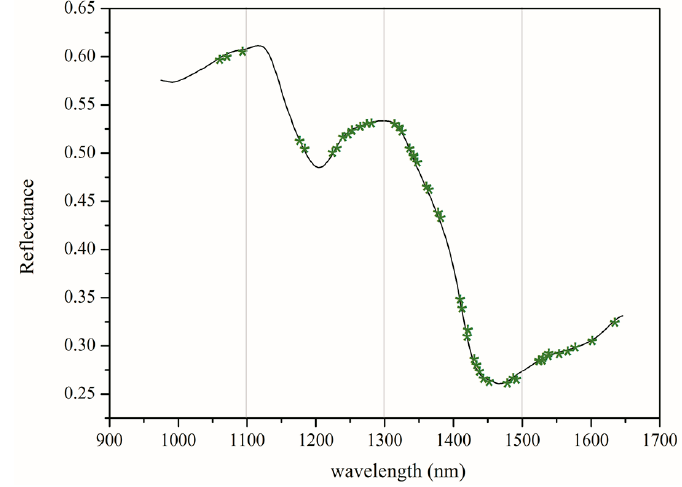
Figure 7. The distribution of optimal wavelengths selected by CARS.